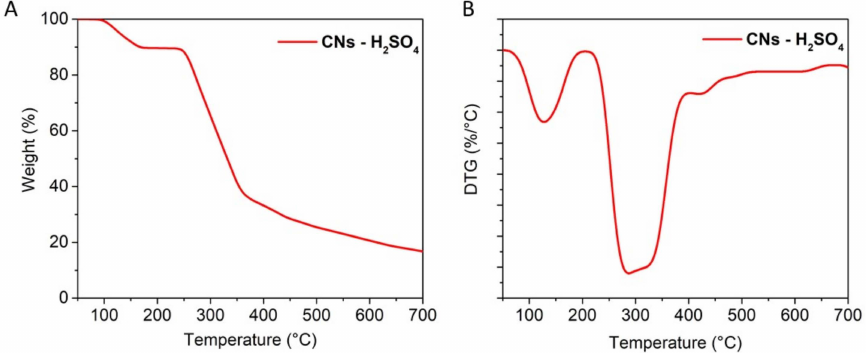
Figure 5. ( A ) Thermogravimetric Analysis TGA and ( B ) Differential Thermal Analysis (DTG) curves of CN samples recorded in